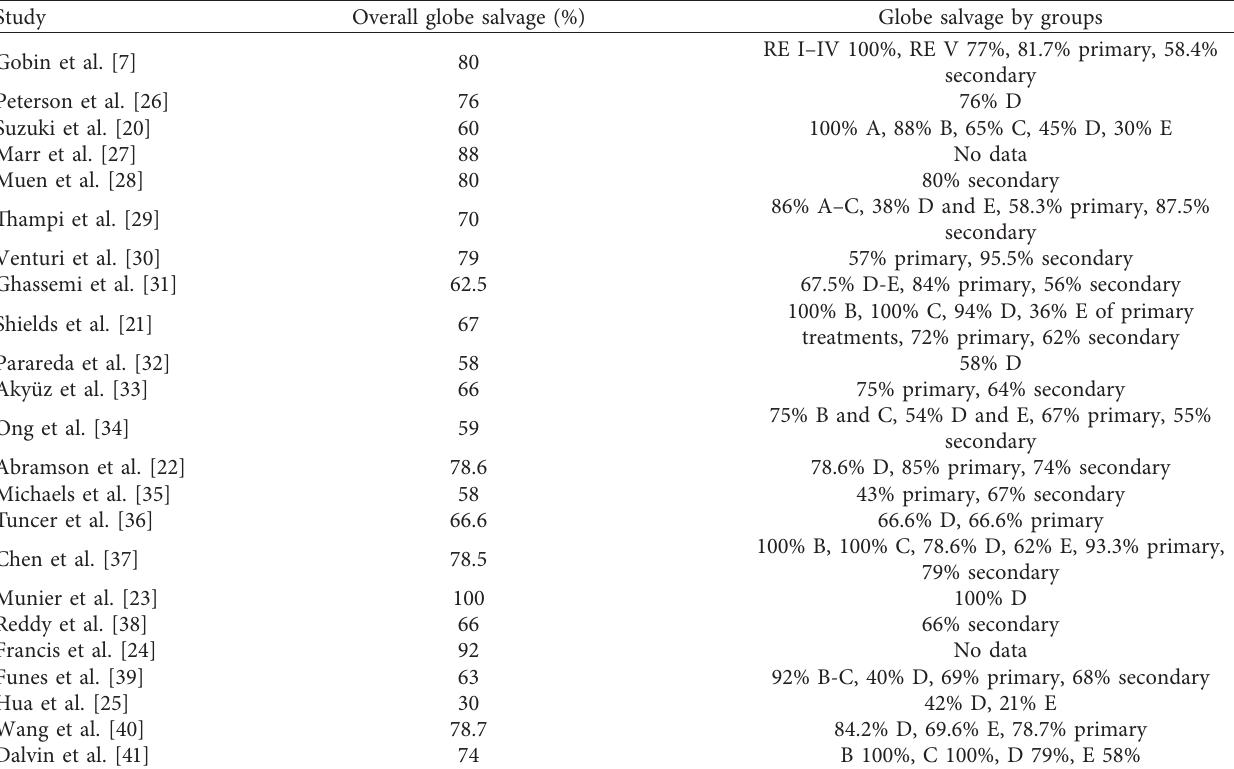
Table 5: Overall globe salvage and globe salvage by groups across analysed